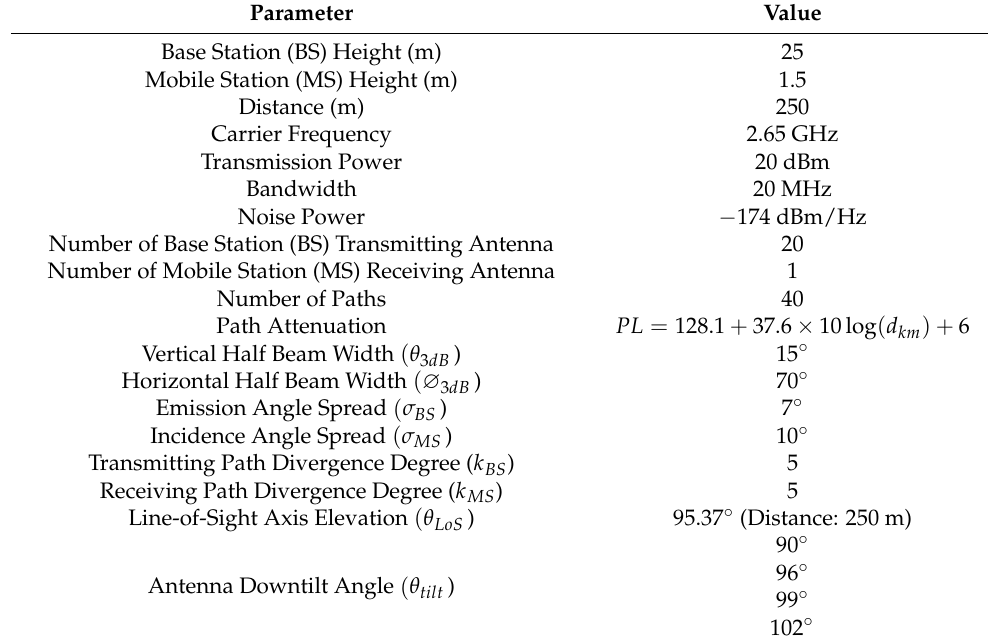
Table 1. Simulation parameters.